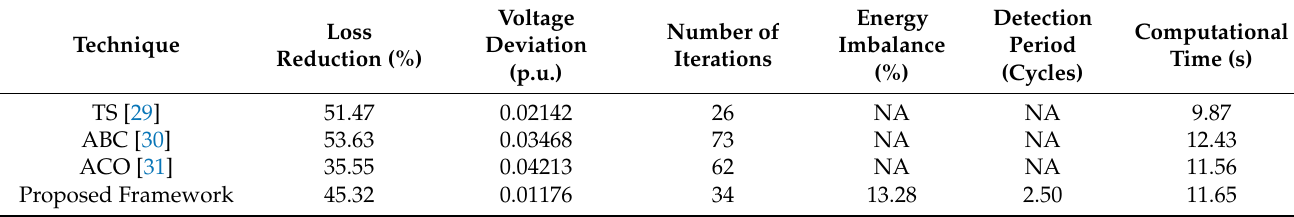
Table 1. Comparative analysis for the optimal placement of the DG and energy management control. TS, Tabu Search; ABC, Artificial Bee